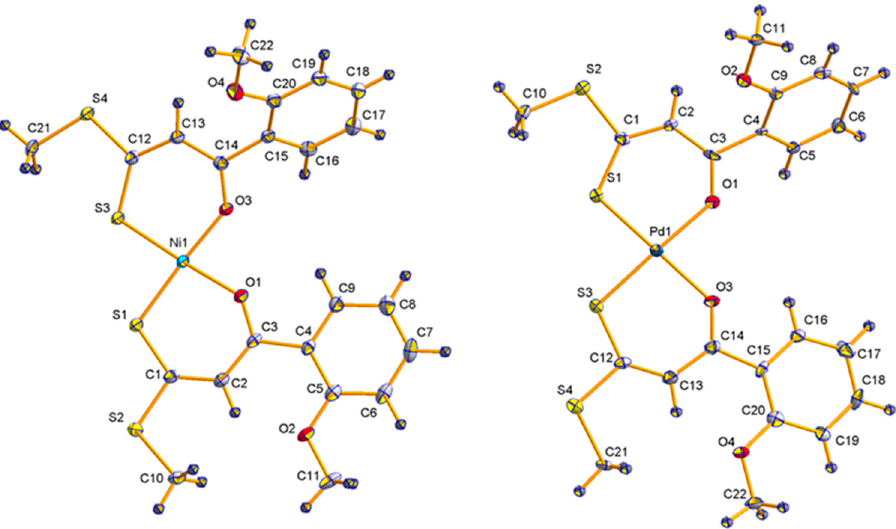
Figure 2. Molecular structures (50% probability) of Ni1 (left) and Pd1 (right). Molecular structures of Ni3, Ni4, and Ni6 are shown in Figure S3.